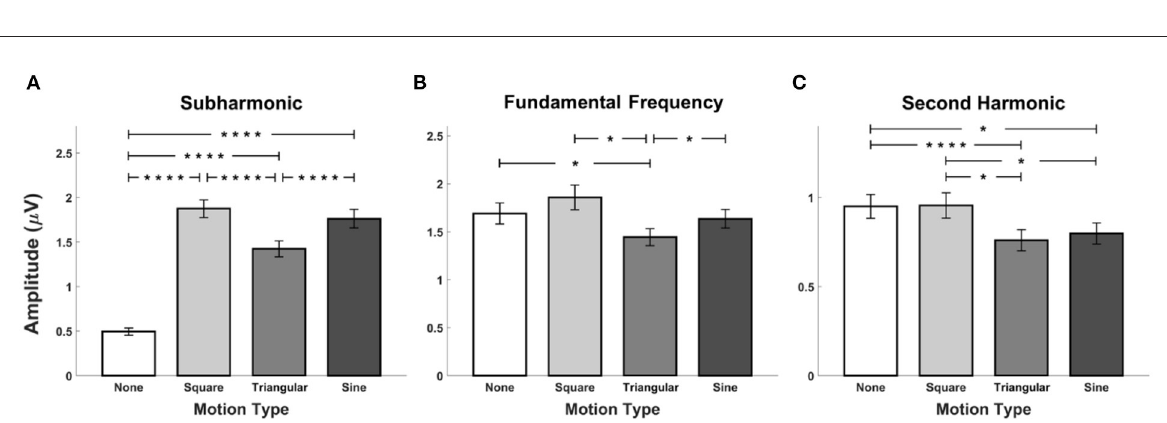
The fatigue scores for PRS-based hybrid visual stimuli are illustrated in Figure 6B as a function of periodic motion waveforms. The gray bars represent the interquartile ranges from 25 to 75% and white circles indicate the median values. For PRS-None, PRS-Square, PRS-Triangular, and PRS-Sine, the averaged fatigue scores were reported as 3.85 ± 1.63, 4.05 ± 1.28, 4.55 ± 1.43, and 4.8 ± 1.51, respectively.